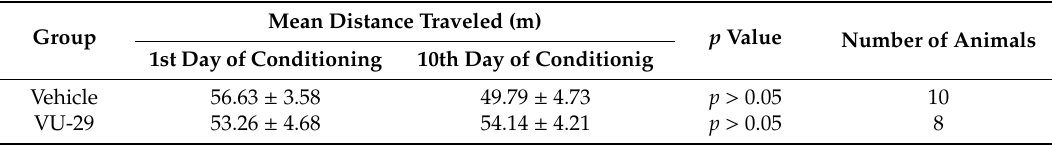
Table 5. The e ff ect of VU-29 on the locomotor activity of rats as measured on the first and last day of conditioning, and recorded as distance (m) traveled in 15 min. Results are expressed as mean ± SEM.